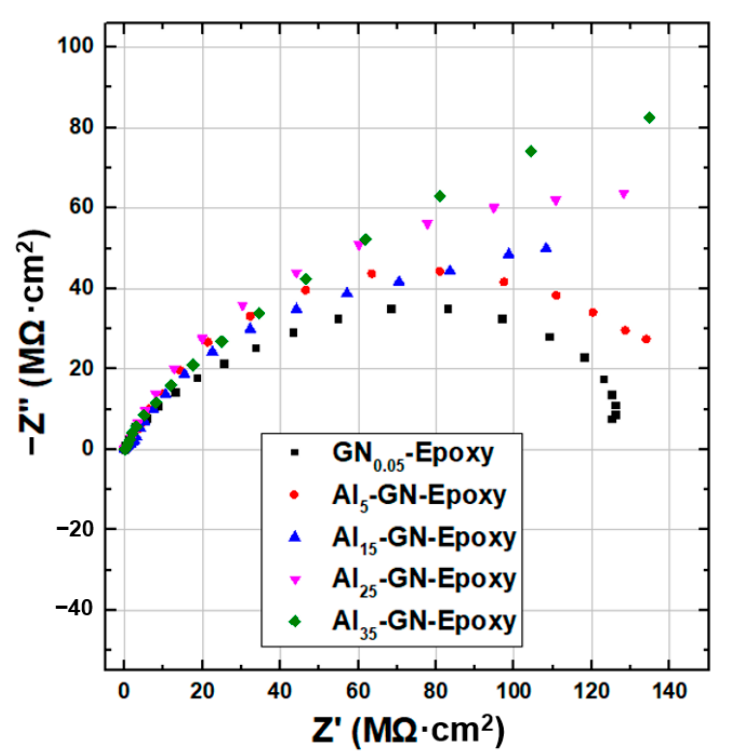
Figure 14. Nyquist plots of EIS for coatings filled with 0.05 wt.% of GN1100 and various contents (5, 15, 25 and 35 wt.%) of Al immersed in 3.5 wt.% NaCl solution. Table 5. Fitted equivalent circuit parameters of EIS for coatings filled with 0.05 wt.% of GN1100